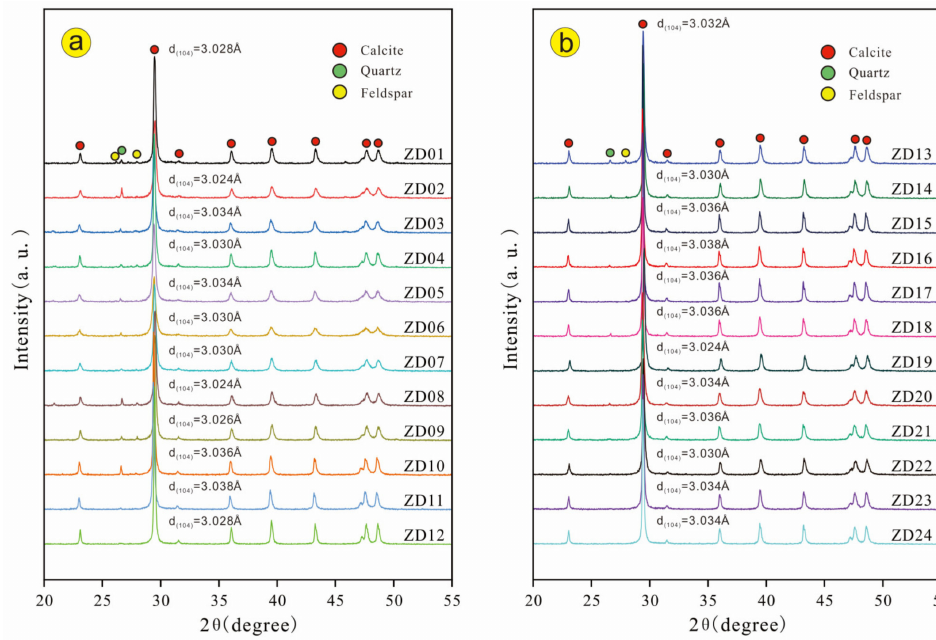
Figure 5. X-ray diffraction patterns of travertine samples. ( a ) X-ray diffraction patterns of samples ZD01-ZD12. ( b ) X-ray diffraction patterns of samples ZD13-ZD24.